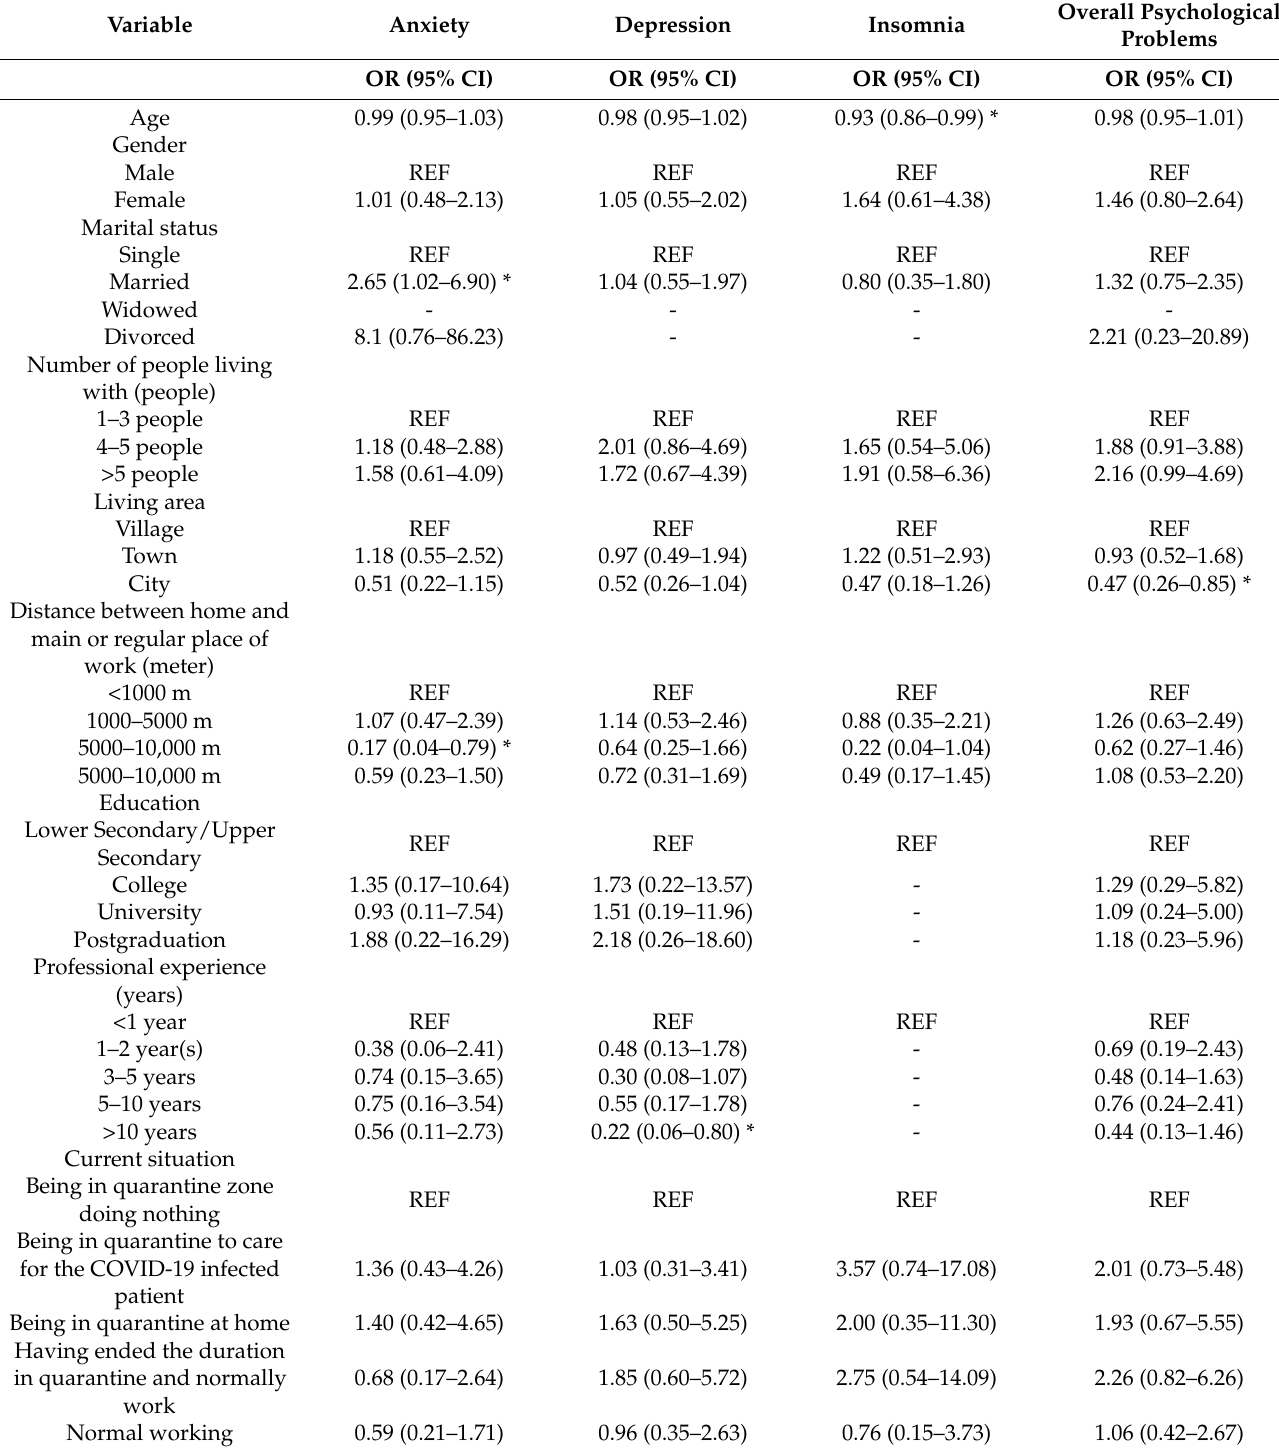
Table 3. Univariable logistic regression analysis of the factors associated with psychological